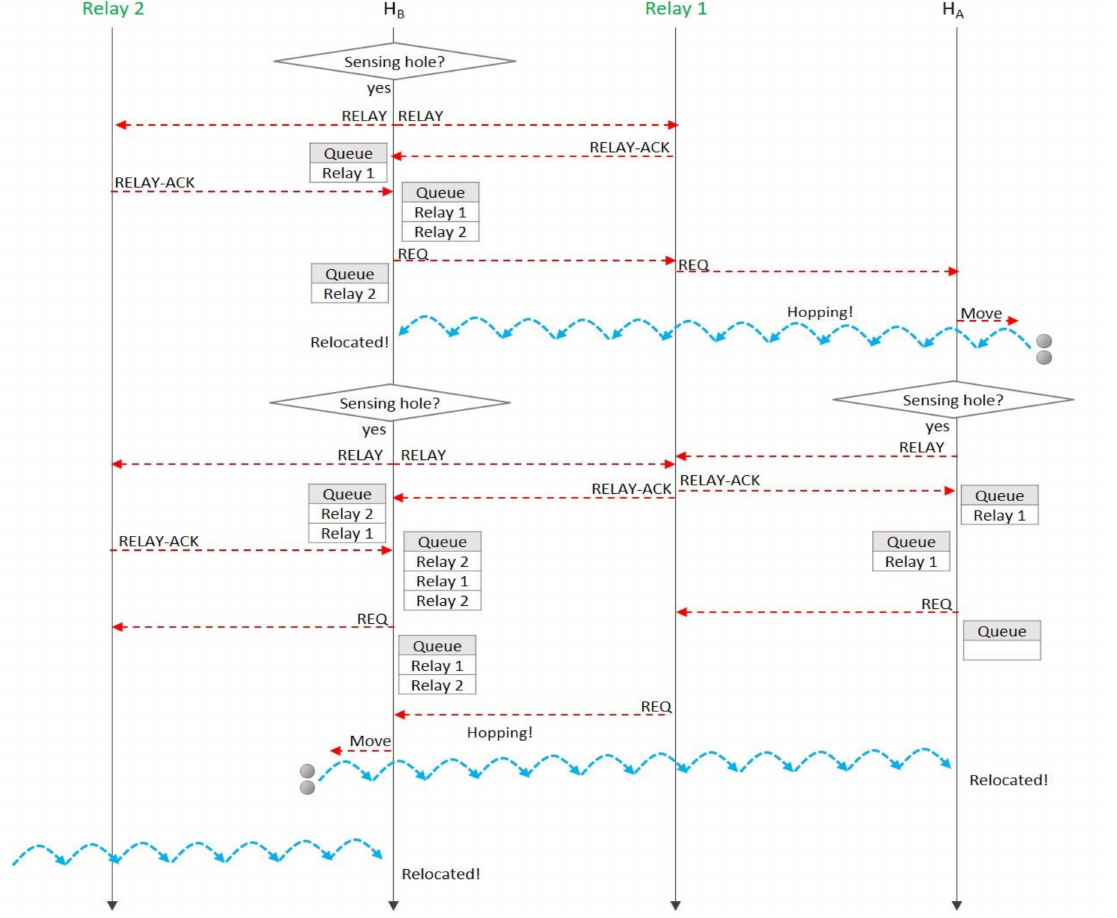
Figure 7. A message sequence diagram for the case study of Figure